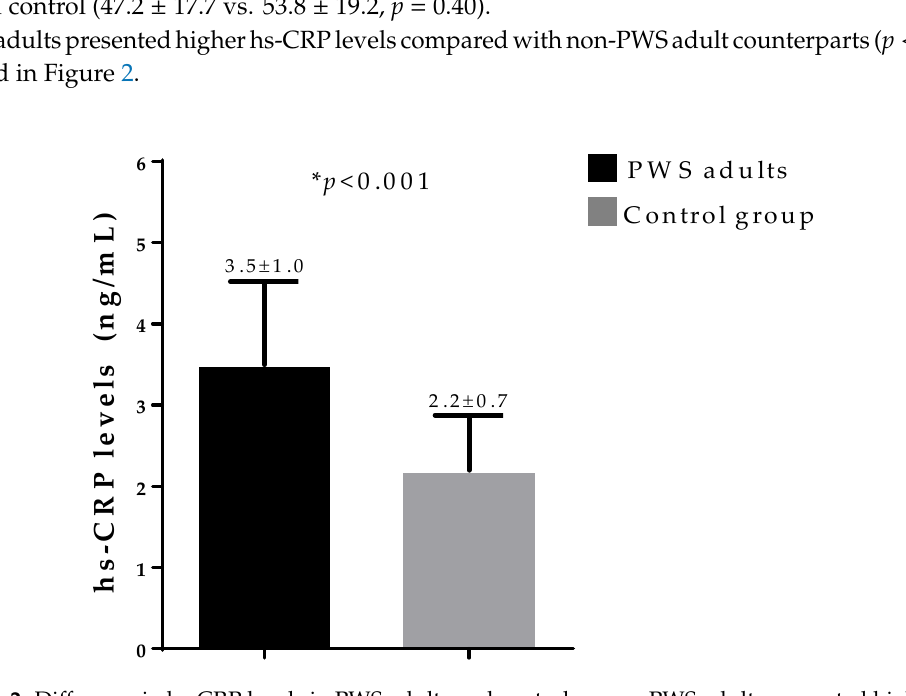
Figure 2. Difference in hs-CRP levels in PWS adults and control group. PWS adults presented higher hs-CRP levels compared with non-PWS adult counterparts ( p < 0.001). PWS , Prader–Willi syndrome; hs-CRP , high-sensitivity C-reactive protein. *A p value <0.05 means a significant difference. 3.1. Correlation Analysis Simple correlations and correlations adjusted for gender, BMI, and waist circumference among PhA and hs-CRP levels with age and anthropometric measurements in PWS adults are reported in Table 2. After adjustment for covariates, significant correlations were found between PhA and hs- CRP levels with ICW, and ECW/ICW ratio. In addition, PhA was also negatively associated with hs- CRP levels (r = − 0.71, p = 0.003). The same correlation analyses were carried out in control group and are reported in supplementary Table S1.